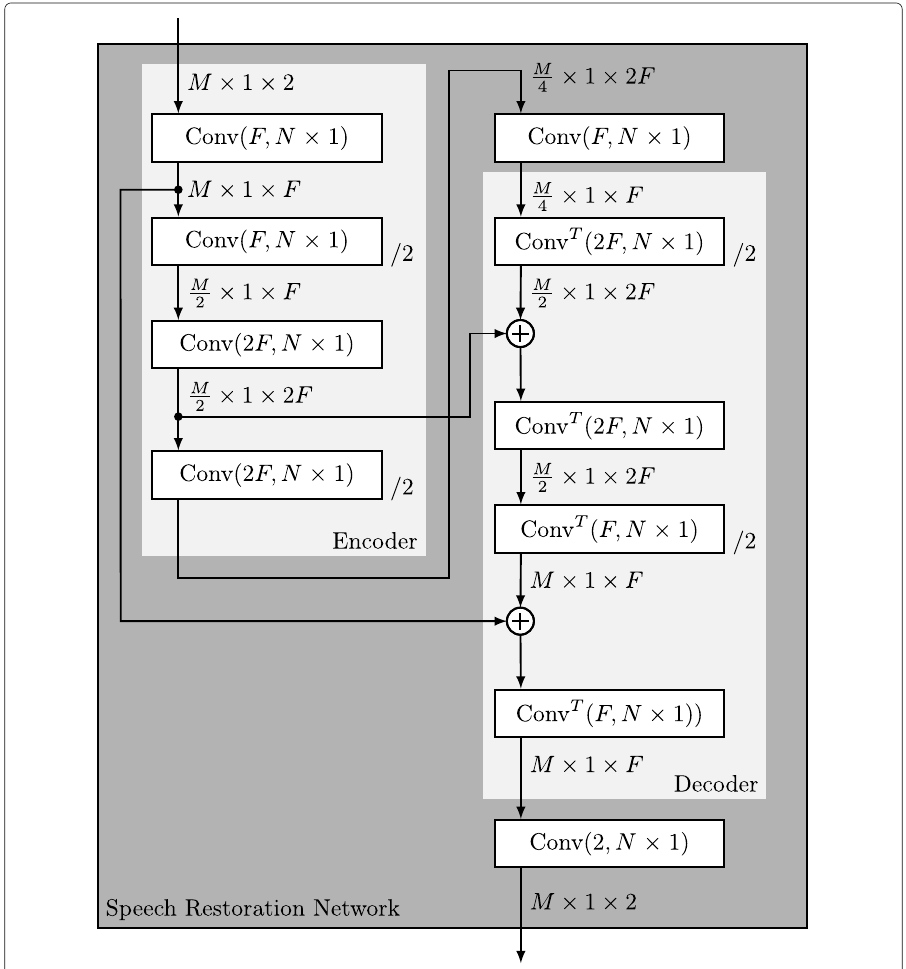
Fig. 4 Block diagram of the speechrestorationnetwork utilizing a CED network including encoder and decoder sub-networks with strided and transposed convolutions ( tr-setup ), where / 2 indicates a stride of 2. The sizes of the feature representations inside the network regarding the frequency, frame, and feature map axis, respectively, are shown at the input and output of each layer